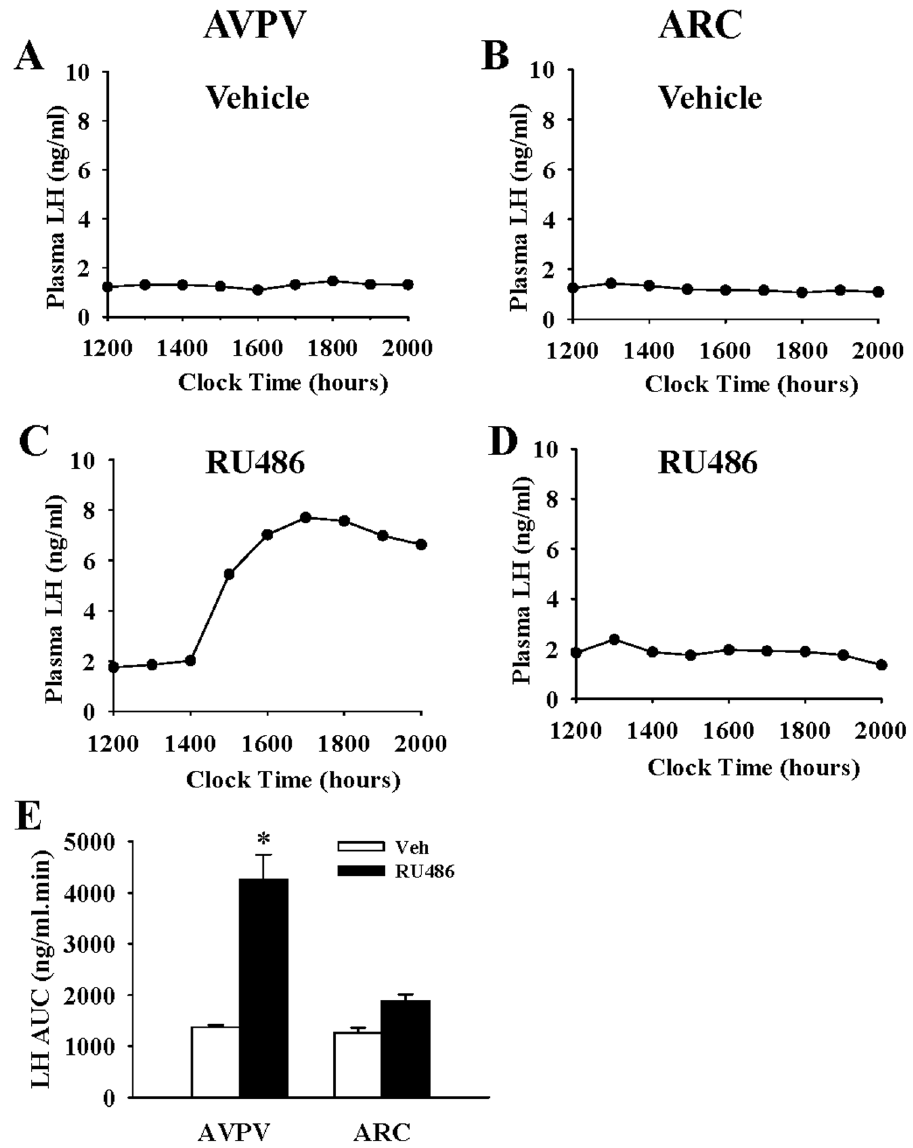
Figure 4. Micro-infusion of RU486 into the AVPV reversed the inhibitory effects of progesterone on the LH surge in PMSG-primed female rats. Representative LH surge on the afternoon of day 2 (day 0, PMSG treatment) in response to intra-AVPV RU486 infusion in a progesterone treated animal ( C ). Intra-AVPV infusion of vehicle (artificial cerebrospinal fluid/DMSO/ethylene glycol) failed to reverse the inhibitory effect of progesterone on the LH surge ( A ). Representative examples showing the absence of LH surges on the afternoon of day 2 following intra-ARC vehicle control ( B ) or RU486 ( D ) after progesterone priming. ( E ) AUC analysis of LH level on the afternoon of day 2 after intra-AVPV or intra-ARC administration with vehicle (Veh) or RU486 in PMSG-treated animals. Results are presented as means ± SEM. * P < 0.05, Veh vs RU486; n = 6–7 per